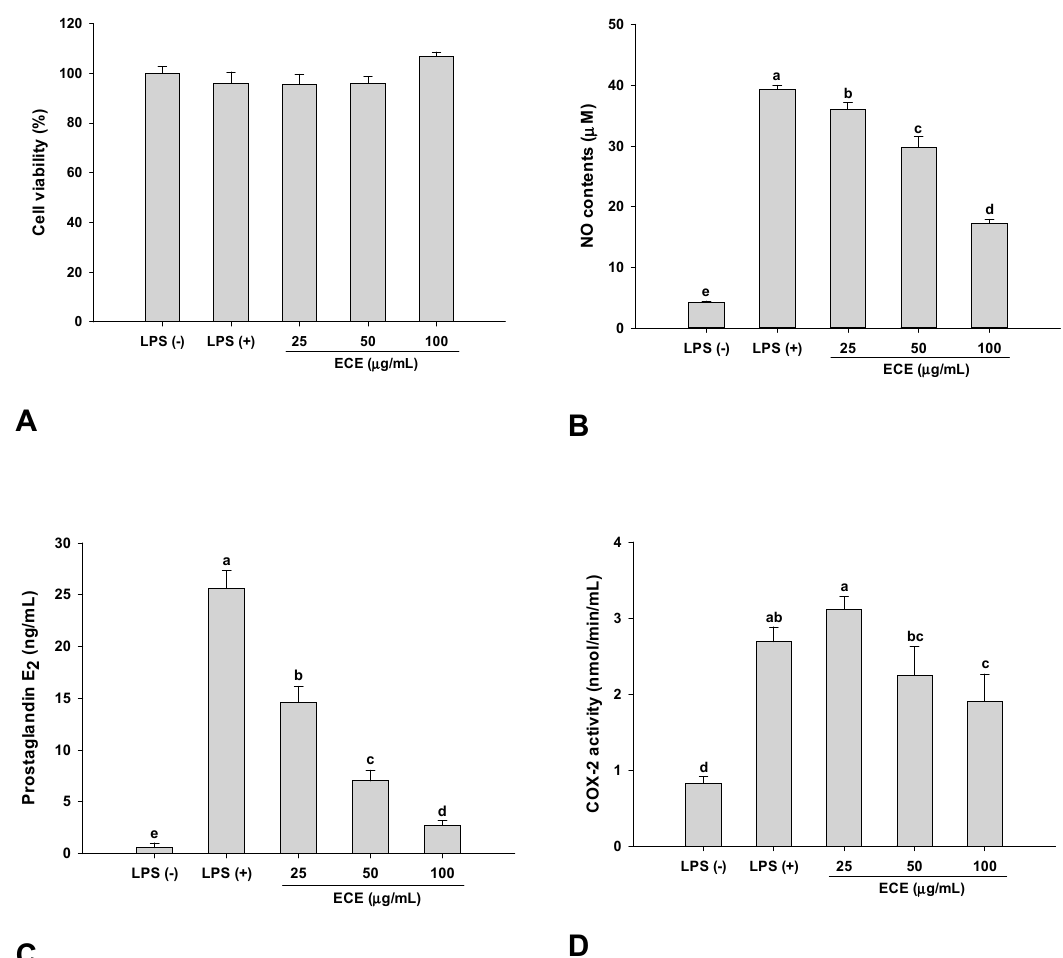
Figure 1. E ff ect of ECE on ( A ) cytotoxicity, ( B ) NO, ( C ) prostaglandin E 2 production, and ( D ) cyclooxygenase-2 activity in Porphyromonas gingivalis LPS-stimulated RAW 264.7 macrophages. ( A ) Cytotoxicity was measured by MTT assay. ( B ) NO was determined using Griess reagent. ( C ) PGE 2 production was analyzed using enzyme immunoassay kit. ( D ) COX-2 activity was measured by enzyme immunoassay kit. Data are presented as mean ± SD and bars with di ff erent letters indicate significant di ff erences at p < 0.05. Cells were treated for 36 h in the presence of P. gingivalis LPS (5 µ g / mL) and samples. ECE: Ecklonia cava extract, LPS: lipopolysaccharide, NO: nitric oxide, PGE 2 : prostaglandin E 2, COX-2: cyclooxygenase 2.